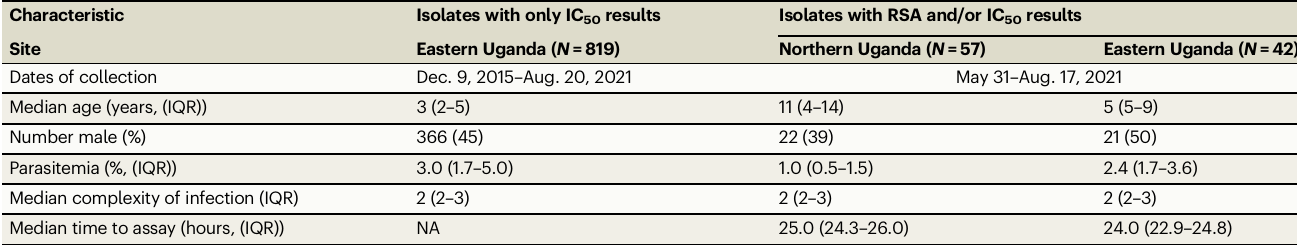
NA not available.